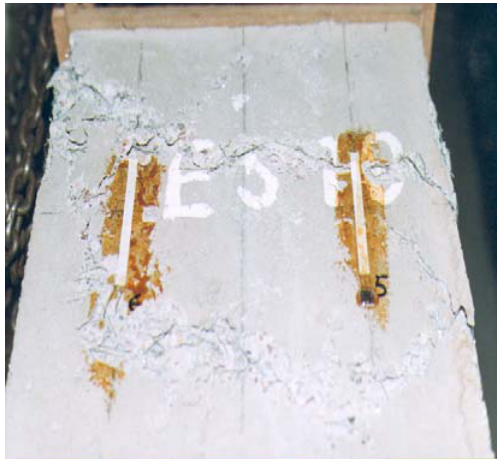
Fig 10 . Character of destruction of column with fibre con- crete head, made of the same concrete mix as the whole column (S10-F)